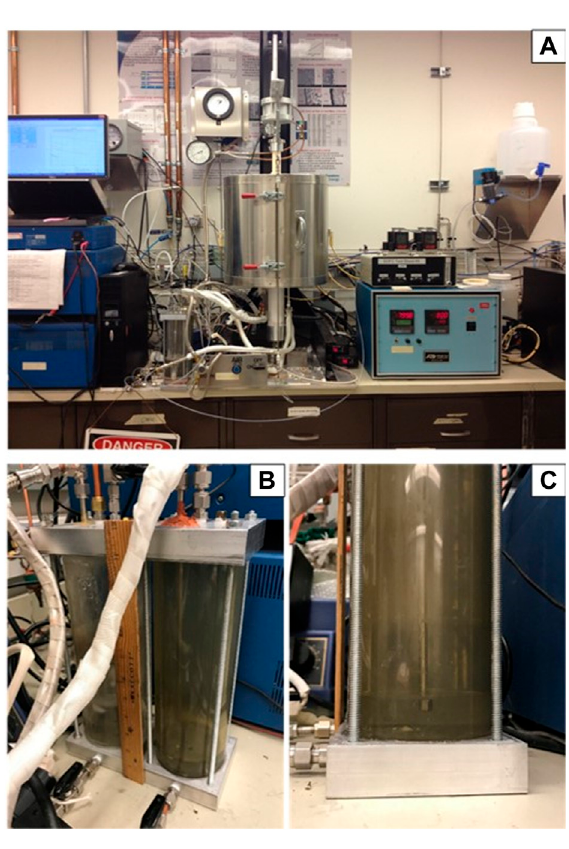
FIGURE 6 Actual set up for a generic stack test, (A) full view of the experimental set-up, (B) , view of the two exhaust water bubblers (one for fuel and one for air), and (C) , enlarged side view of the bubbler with ~0.2 – 0.5 inch of water above the tubeing